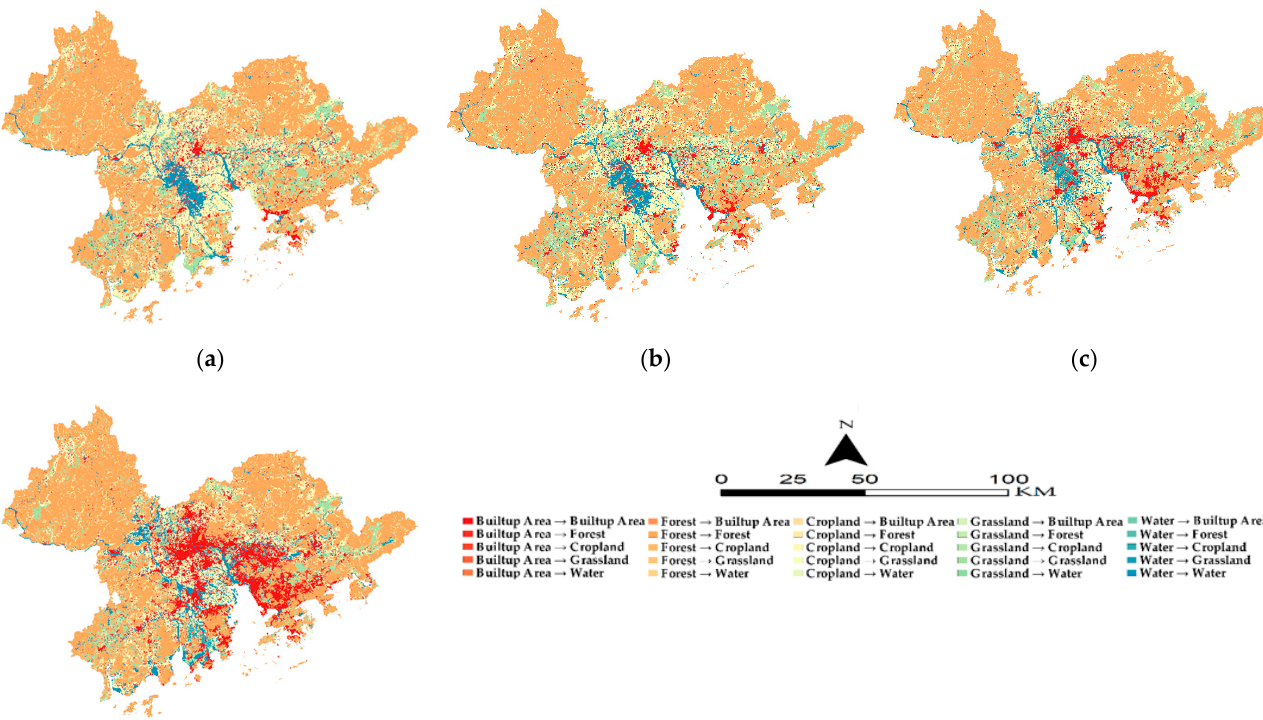
Table 3. LULC area from 1980–2020 (km 2 ) and annual rate of change (ARC). LULC Type Built-up Area 2600.79 LULC Type Forest Cropland Grassland Water The LULC change analysis explored the spatial dynamic variations in the LULC pat-